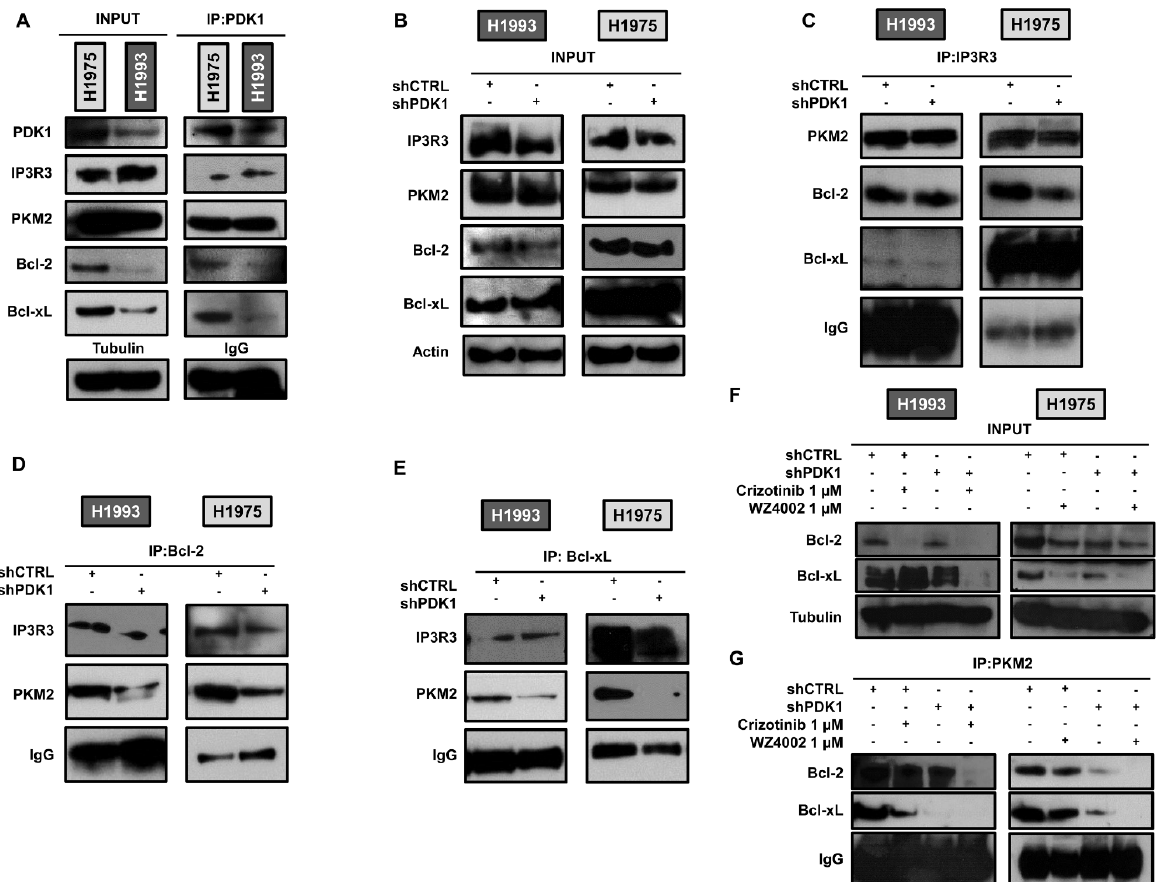
Figure 4. PDK1-dependent protein–protein interactions by immunoprecipitation assays. ( A ) Direct or indirect interactions of PDK1 and selected proteins at the ER–mitochondria interface in H1993 and H1975 parental cell lines. ( B ) Levels of indicated proteins in whole cell lysates of shCTRL and shPDK1 H1993 and H1975 cells. ( C ) Immunoprecipitation with anti-IP3R3 antibody and blotting for the indicated proteins. ( D ) Immunoprecipitation with anti-Bcl-2 antibody and blotting for the indicated proteins. ( E ) Immunoprecipitation with anti-Bcl-xL antibody and blotting for the indicated proteins. ( F ) Whole lysates of untreated and treated shCTRL and shPDK1 H1993 and H1975 cells subjected to ( G ) immunoprecipitation with anti-PKM2 antibody followed by blotting for the indicated proteins. Tubulin and actin served to ensure equal loading. The uncropped Western Blot images can be found in Figures S15–S22.